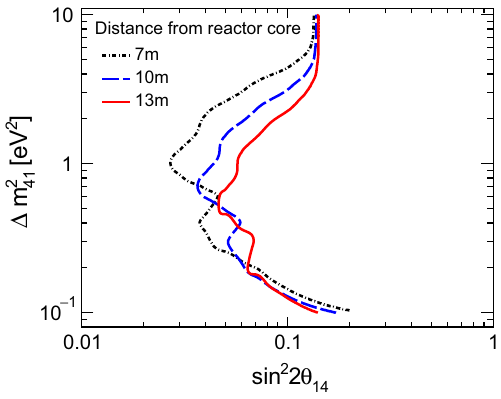
− sin 2 2 θ 14 plane, 41 ( 1 − U ) 2 , expected from 1ton-year of e 4 e 4